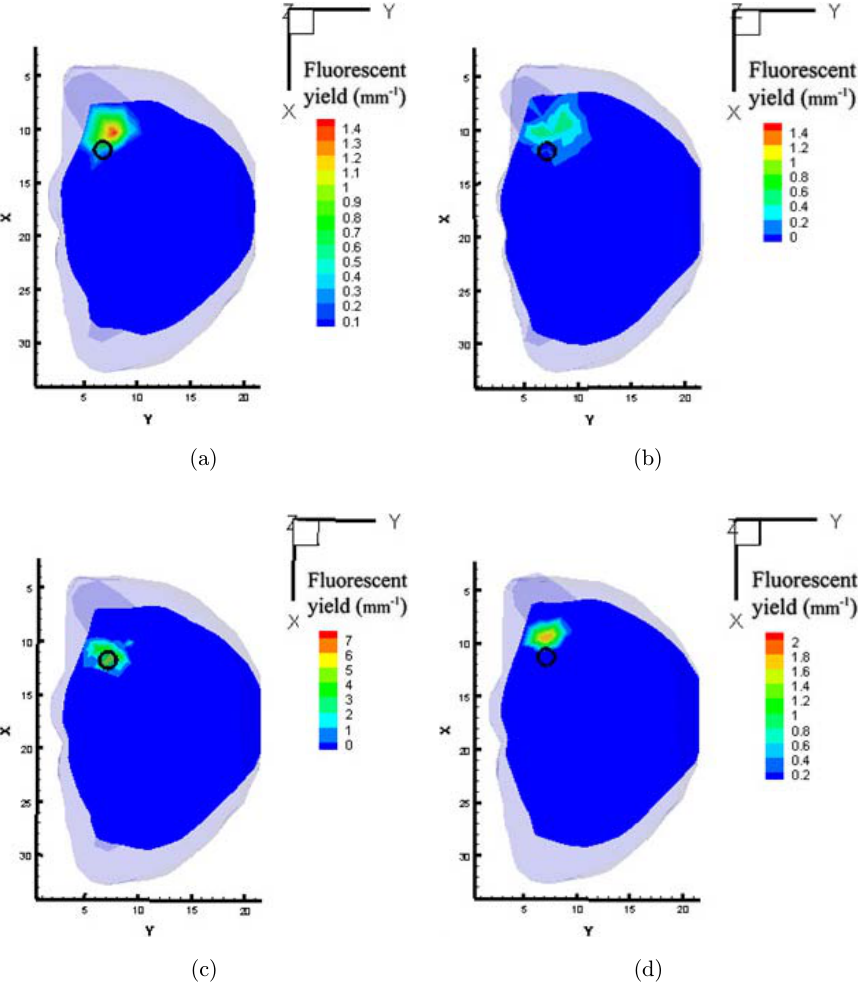
Fig. 5. Transverse view of the reconstruction results in highly absorbing media, where the black circles represent the real target. (a) Result of SP N model on the initial mesh level. (b) Result of DA model on the initial mesh level. (c) Final result of SP N model with hp- FEM. (d) Final result of DA model with hp-